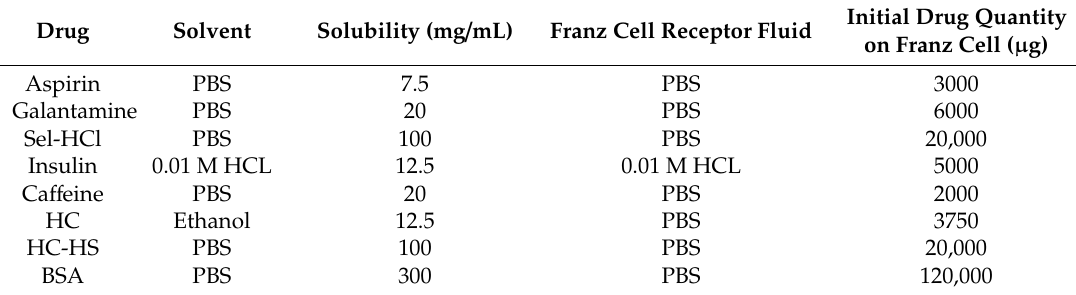
Table 2. Franz cell experimental condition for mosaic